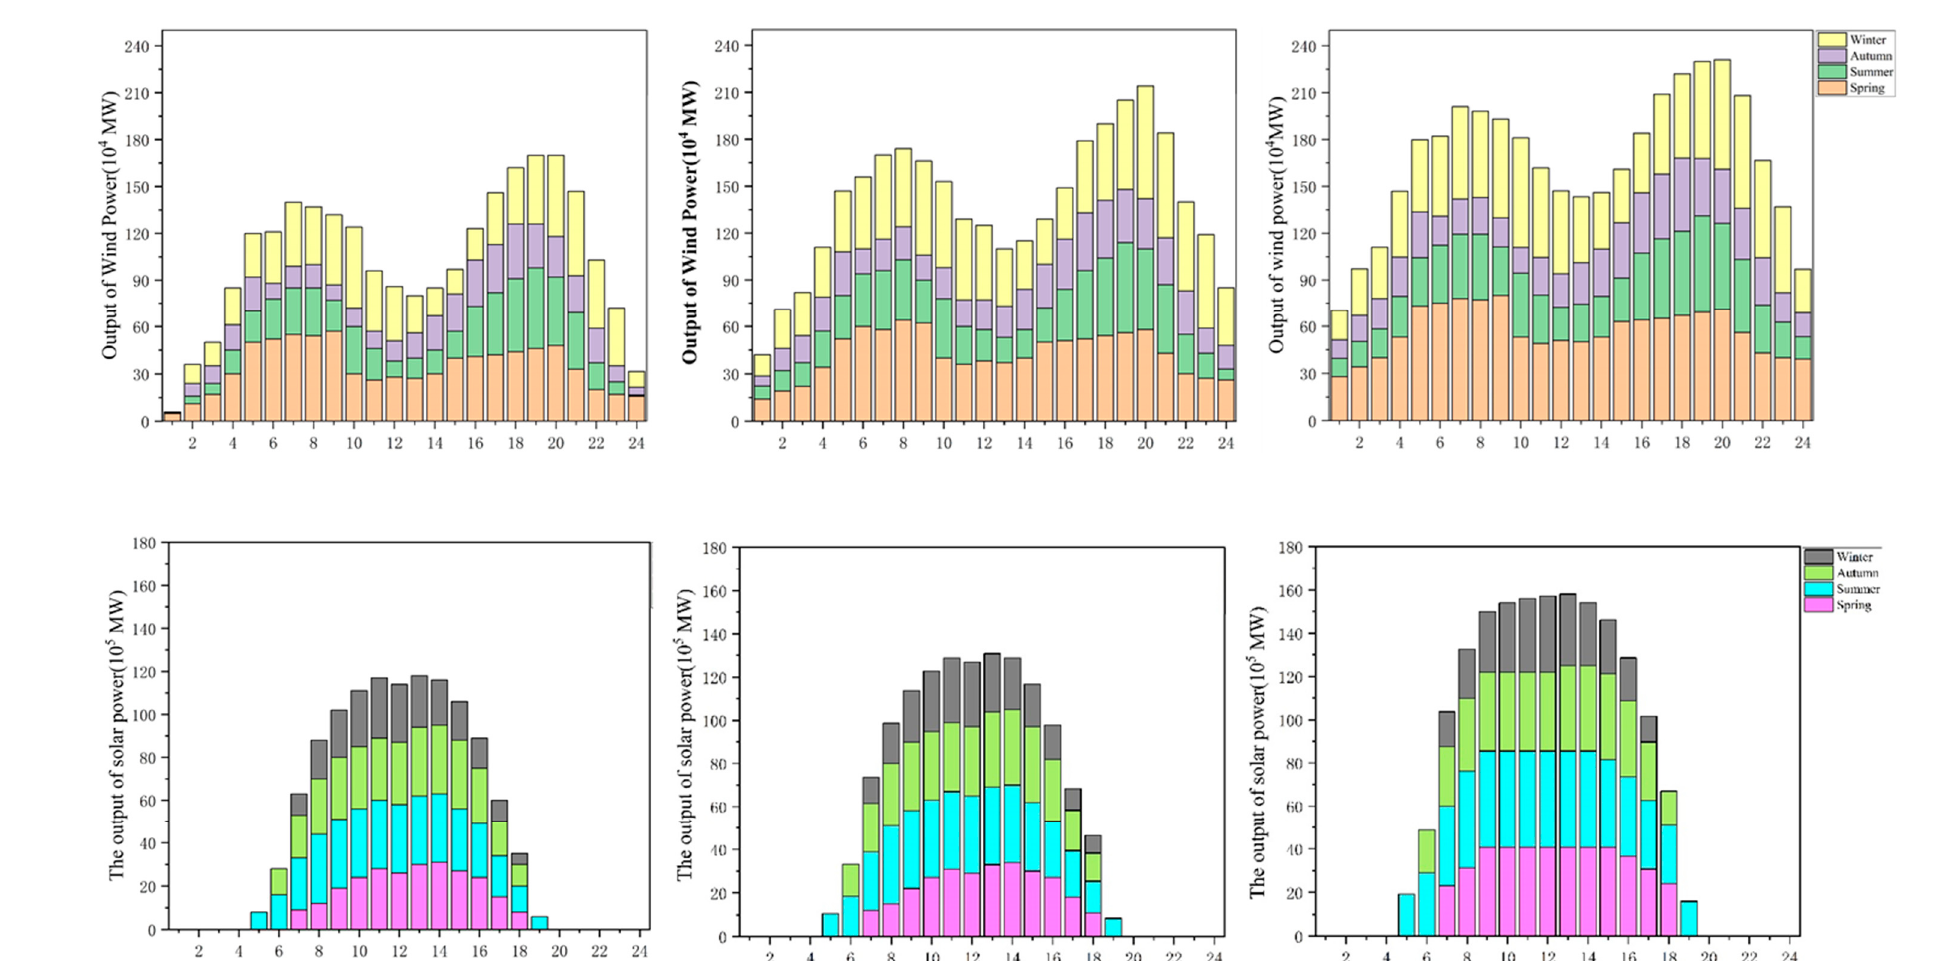
Figure 5. The output of wind and solar power in different periods (MW).